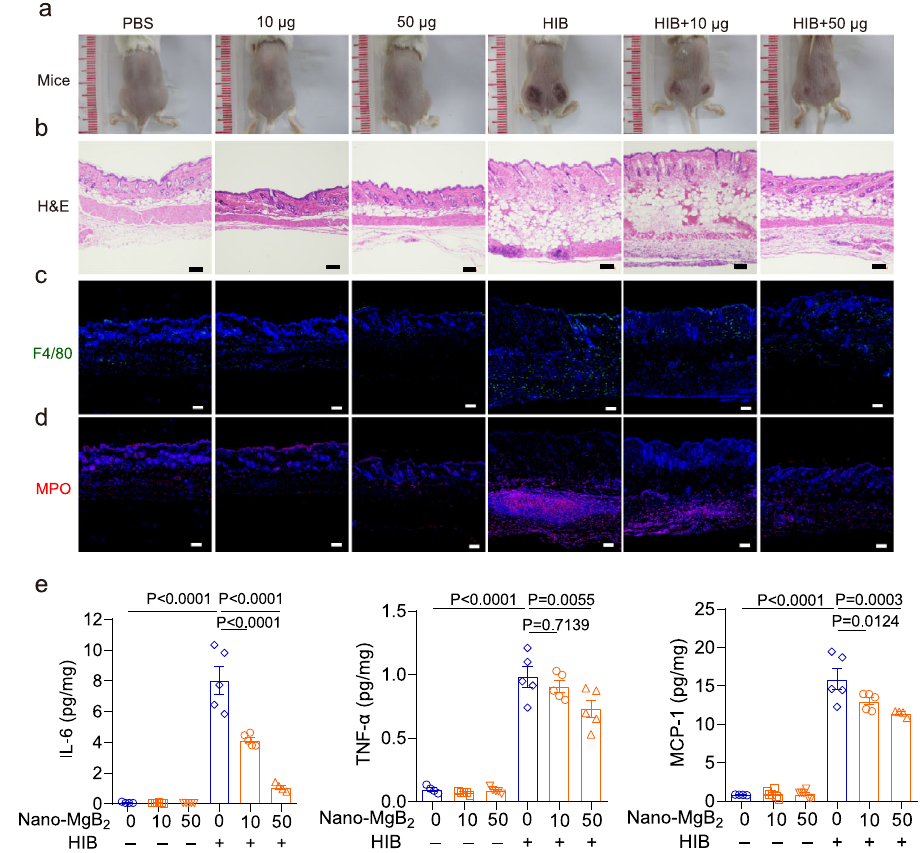
Fig. 7 | Nano-MgB 2 inhibited dead bacteria-induced skin in fl ammation in vivo. a Photographs of dead bacteria-induced (HIB, heat-inhibited bacteria, P. aerugi- nosa )mouseskinin fl ammationtreatedwithorwithout10 μ gand50 μ gNano-MgB 2 ( n =5). b H&E staining of HIB-induced mouse skin taken as in ( a ). Scale bar=100 μ m. Immuno fl uorescence staining with the ( c ) macrophage cell marker F4/80 and ( d ) neutrophil cell marker myeloperoxidase (MPO) of HIB-induced mouse skin